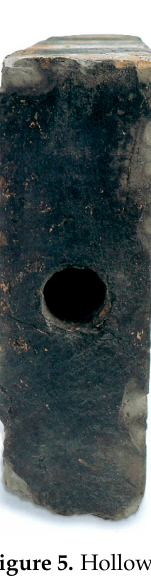
Figure 5. Hollowed brick that encased a printed scroll. Found in the ruins of the Leifengta, Hangzhou, Zhejiang Province, China. Ca. 975 CE, Wuyue (907–978). L. 37 cm; W. 18 cm; D. 6 cm. Zhejiang Provincial Museum. After (Li 2010, p.